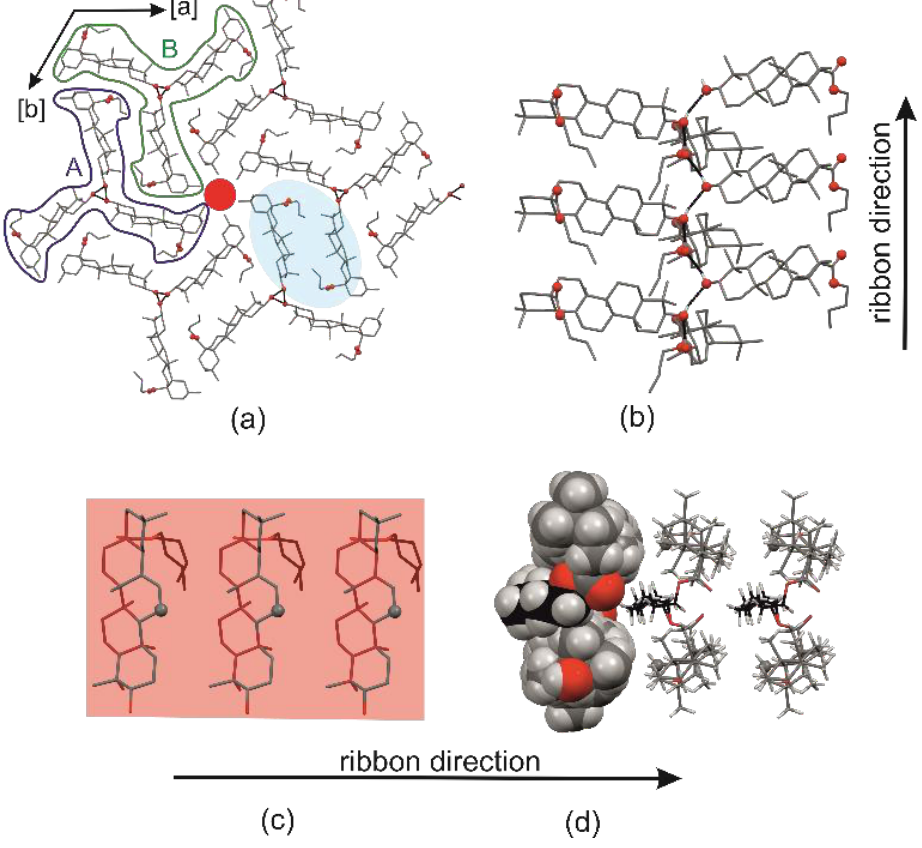
Figure 4. R 3-but-OA ( a ) three-dimensional structure, ( b ) helix, ( c ) Rb HH ribbon of molecule B, and ( d ) A/B ribbon dimer, shown along triterpene long axis. In ( a ), the symmetry-independent propeller- shaped H-bonded helices are marked with blue and green lines; voids between E rings are marked with red circles; and the ribbon dimer is shaded with a blue ellipse. The O-H···O hydrogen bonds are shown as black lines in ( a , b ). In ( c ), the C11 atoms in C rings are shown as balls; the ribbons’ plane is shown in light red. In ( a – c ), H atoms are omitted for clarity. The butyl substituents are colored black in ( c , d ).